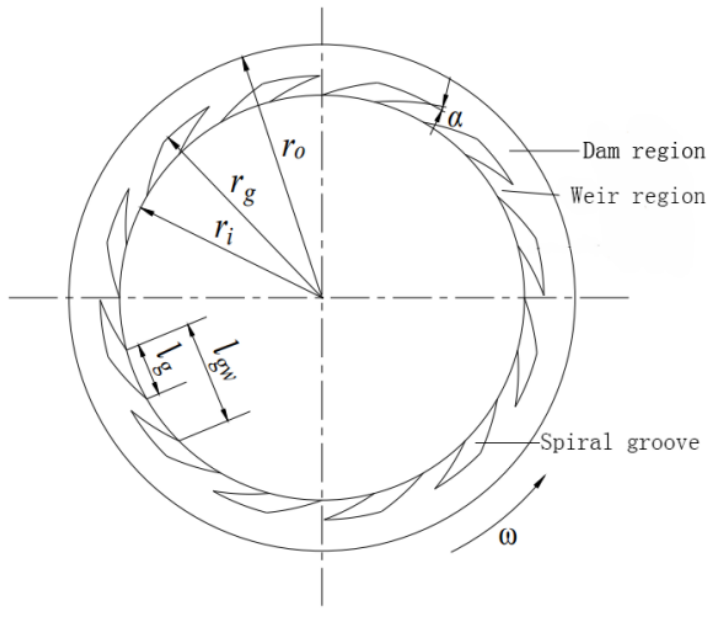
Figure 1. Spiral groove shape of the end face of the mechanical seal rotational ring. Table 1. Geometric parameters and numerical values of the seal face.